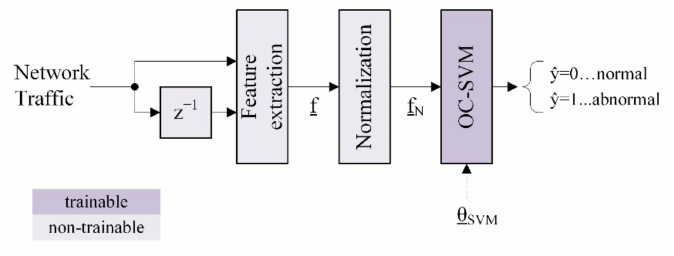
Figure 5. Basic architecture of the anomaly-based NIDS using an